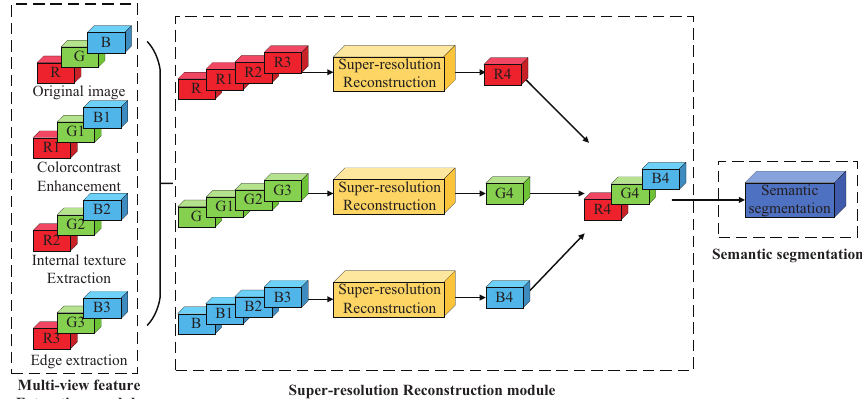
Figure 1. Block diagram of the semantic segmentation module. It consists of three parts. The left side represents the multi-view feature extraction module. The middle part represents the super-resolution feature reconstruction module. The right side represents the semantic segmentation module.